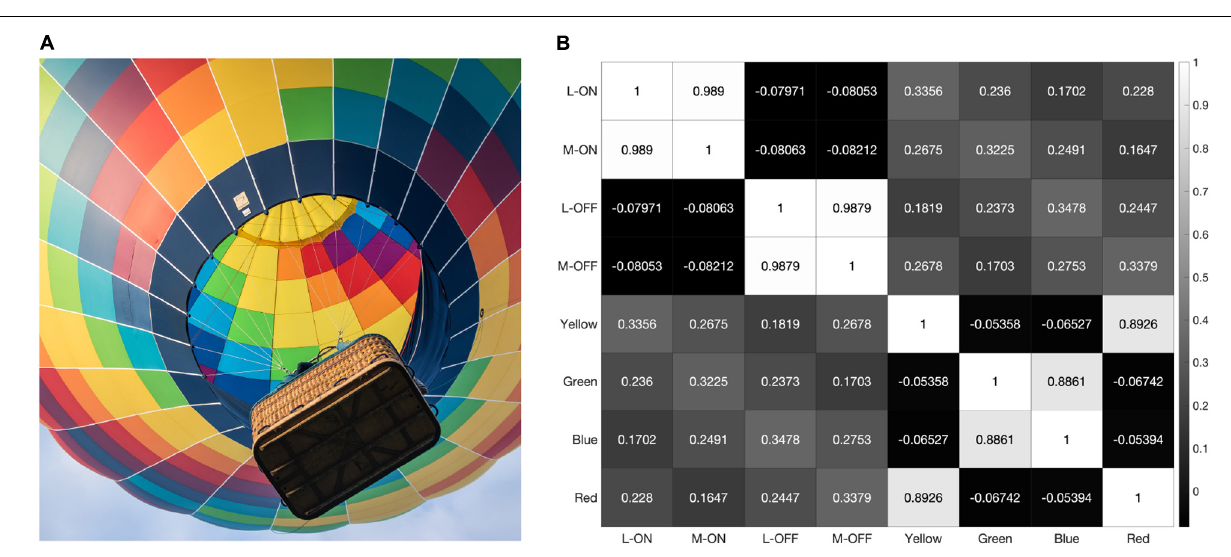
between the single-opponent and double-opponent receptive fields in our model and a strong correlative effect on the responses of the two single-opponent receptive fields. This is because the